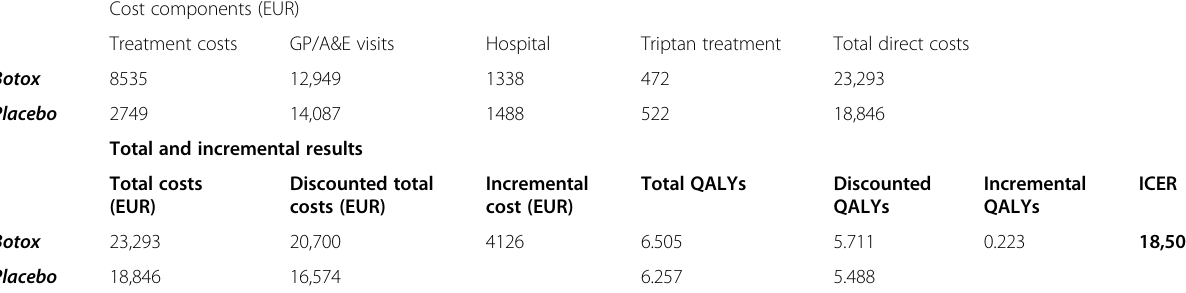
Table 6 Base case results, Sweden Cost components (EUR)